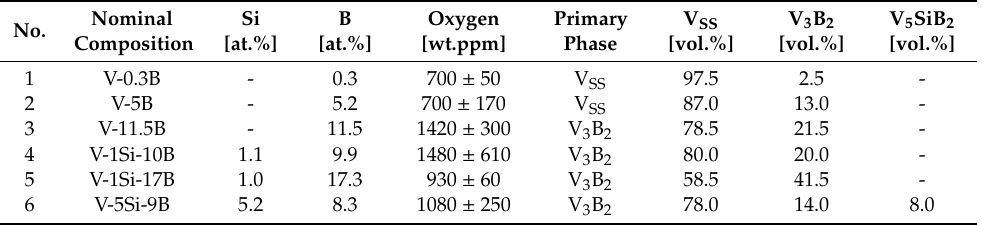
Table 1. Chemical composition, primary phase and phase volume fractions of as-cast V(-Si)-B alloys. Nominal Si No. Composition